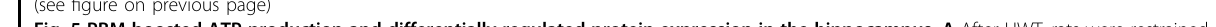
increase expression in the UWT-group (Fig. 5E left panel)